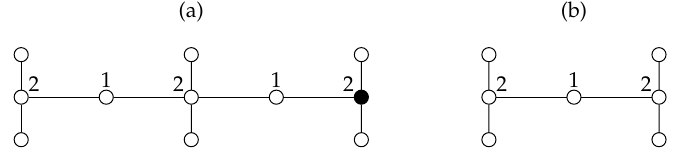
Figure 4. Graphs H and H − N [ v ] with different labellings (vertices with no drawn label have label zero) to show that γ tR ( H ) = 8 ( a ) and γ tR ( H − N [ v ]) = 5 ( b